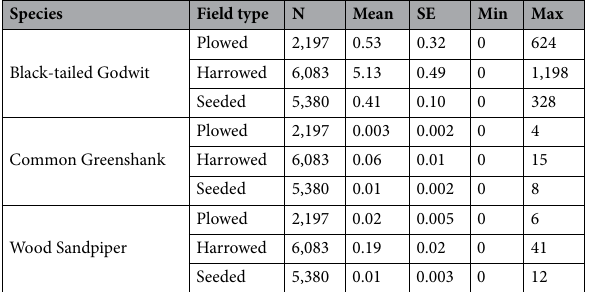
Table 1. Number of shorebirds observed in each rice paddy field type. N = total number of paddies during survey periods, SE = standard error, Min = minimum number of birds per paddy, and Max = maximum number of birds per paddy.